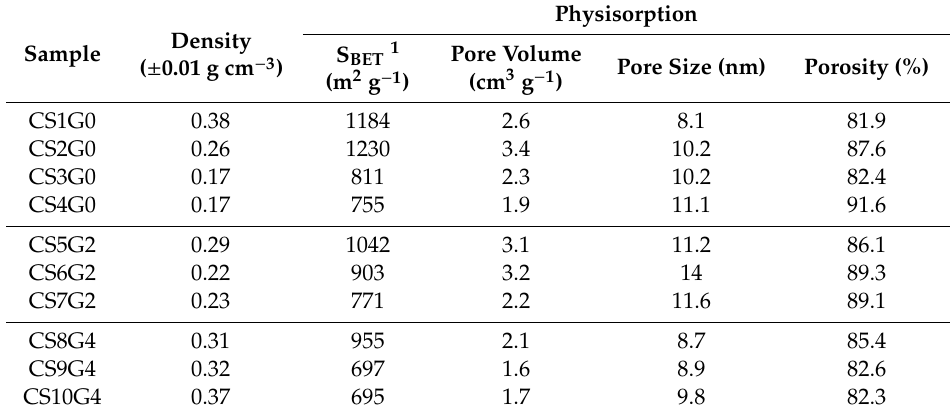
Table 2. Bulk density and textural data from N 2 physisorption for CS-GPTMS-Silica hybrid